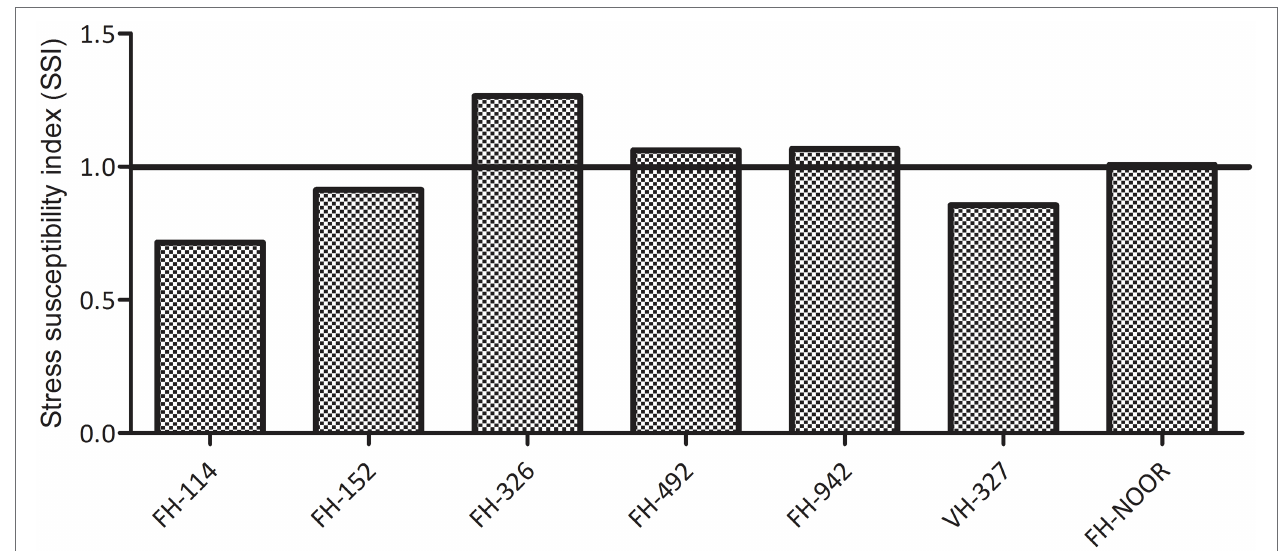
FIGURE 3 | Stress susceptibility index of cultivated varieties of Gossypium hirsutum on exposure to